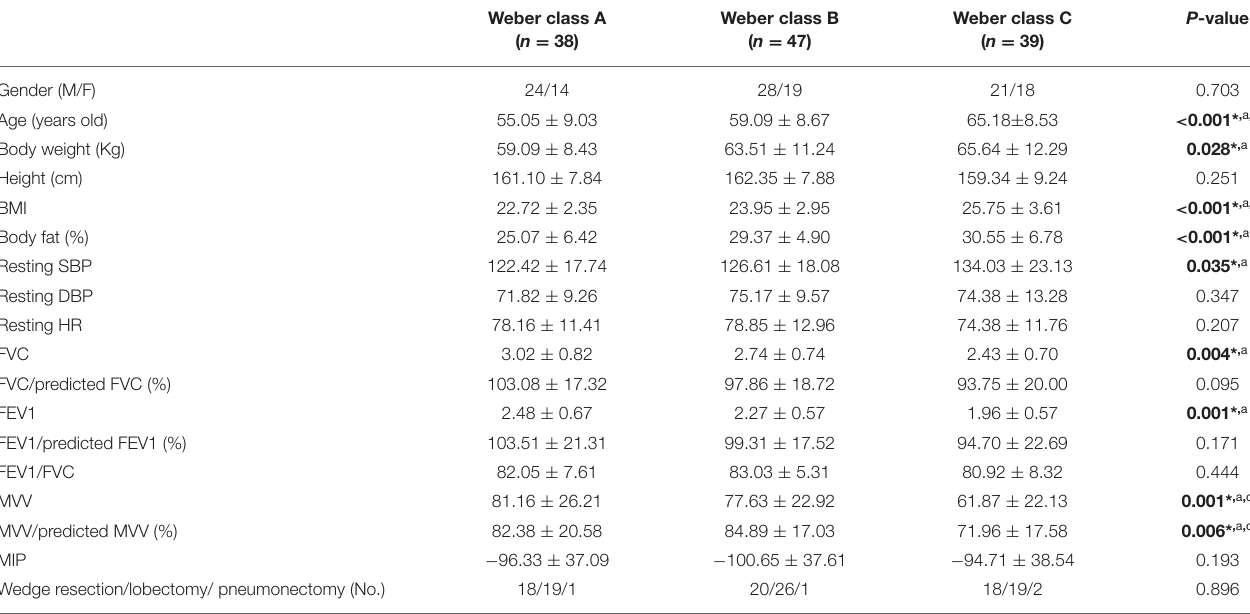
TABLE 2A | Baseline characteristics of each group defined by peak oxygen consumption (peak VO 2